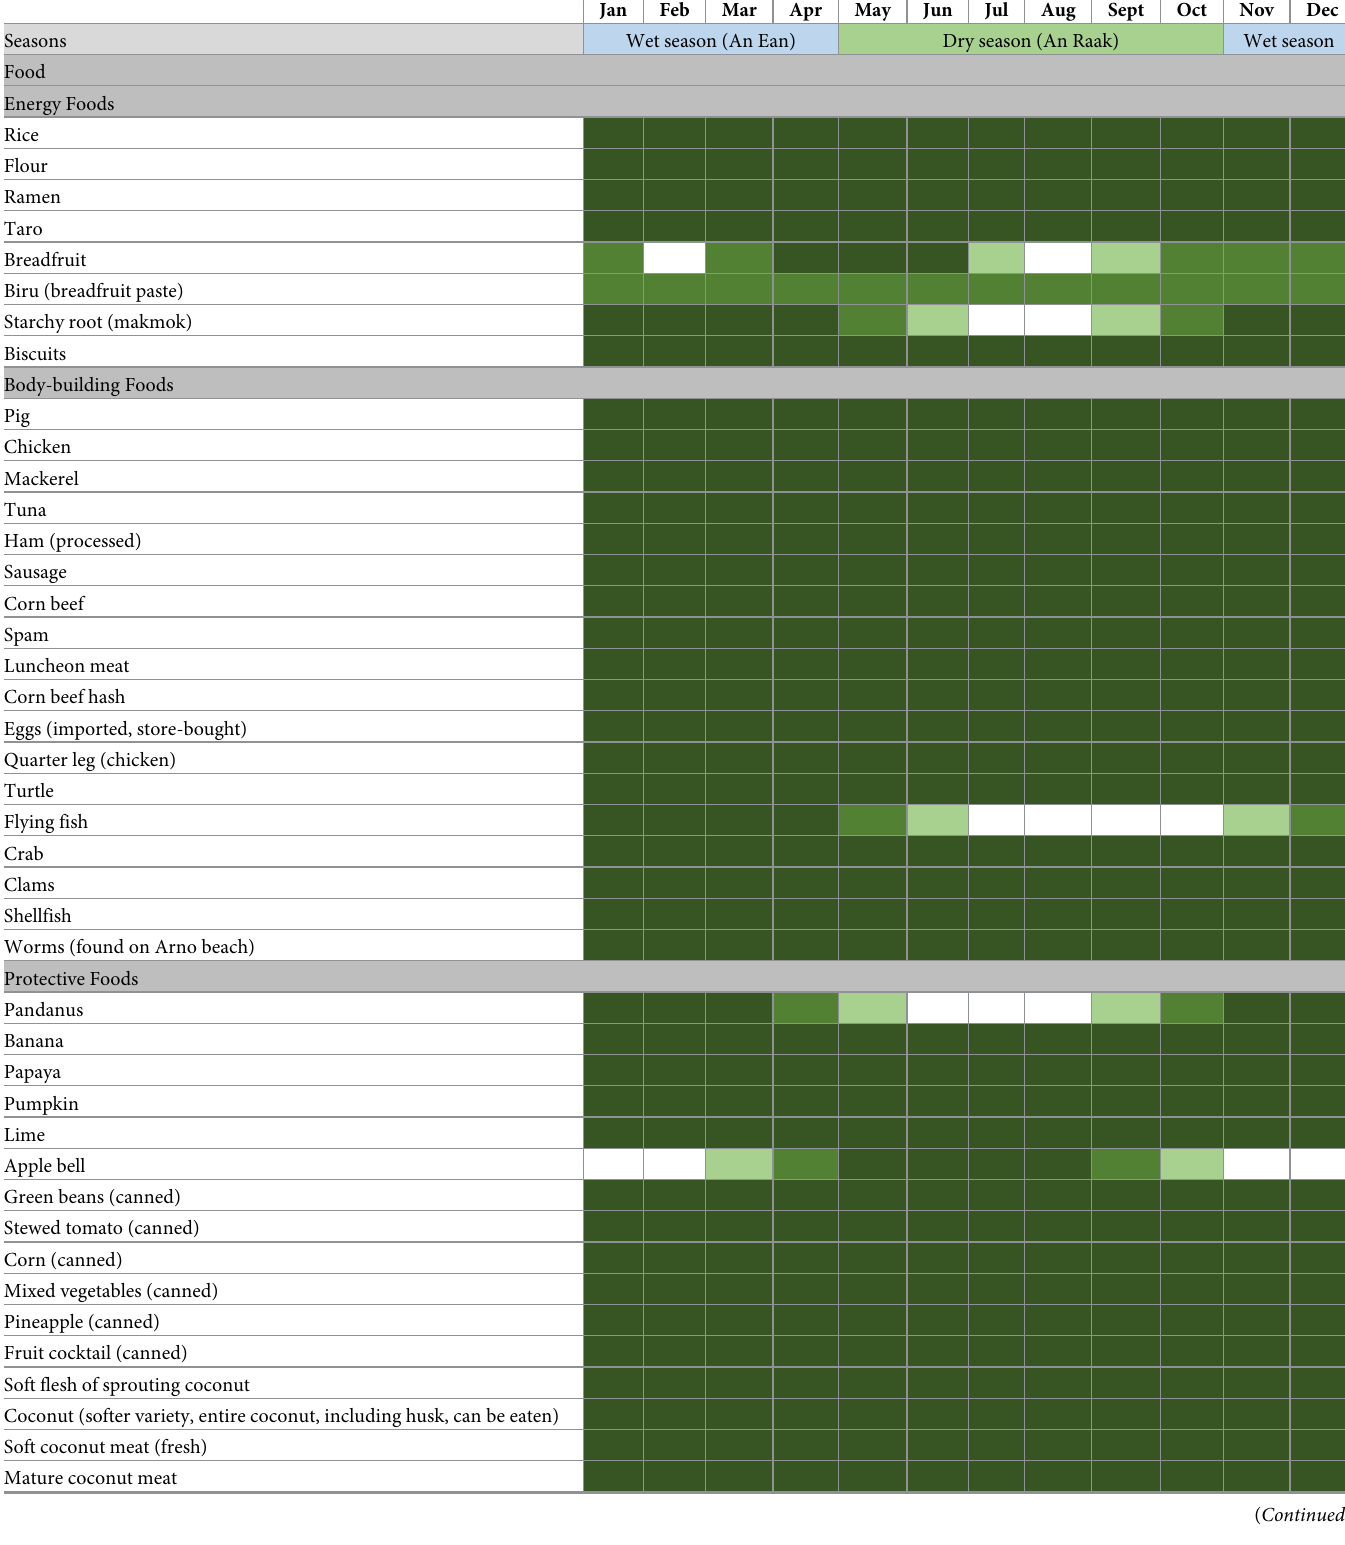
Table 3. Seasonal food availability calendar for Arno